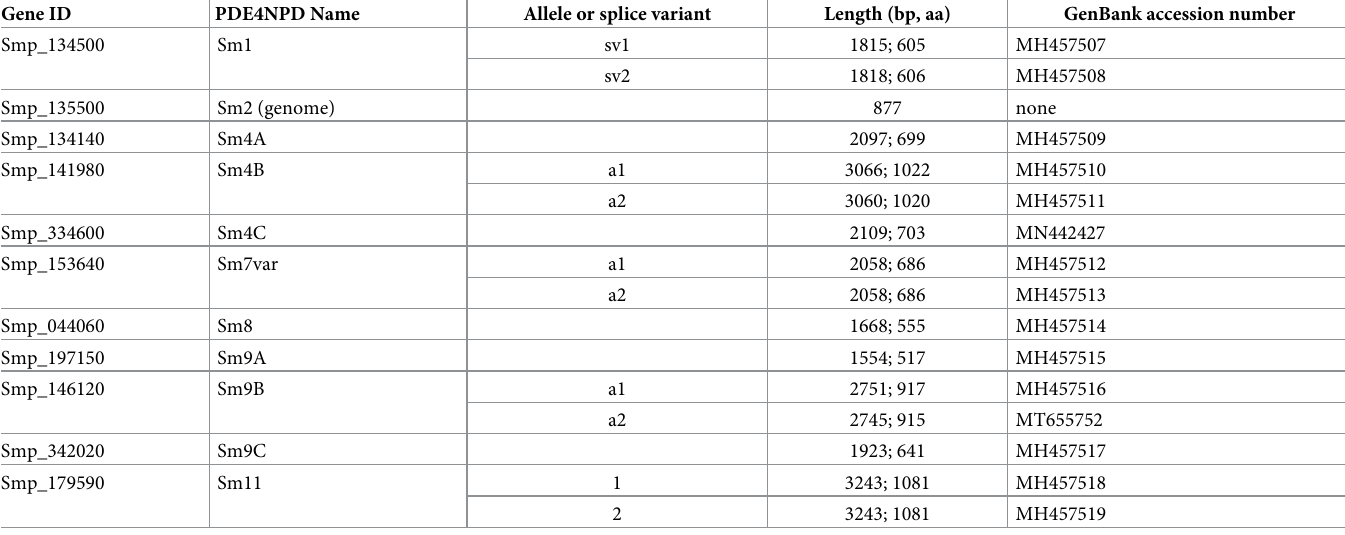
Table 1. Systematic naming of SmPDEs.